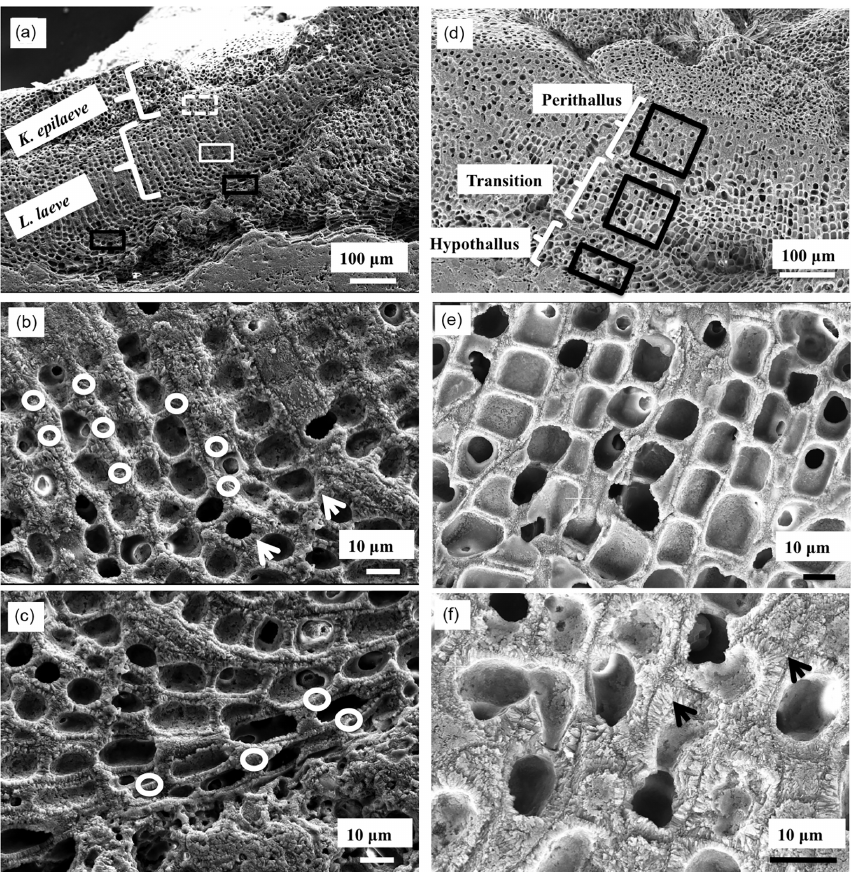
Figure 3. Overview of L. laeve and K. epilaeve and EDS sites (white circles) in L. laeve . (a–c) Sites on the underside of the pebble. (d– f) Sites on the upper side of the pebble. (a) White dashed box – cell wall and interfilament in K. epilaeve . White box – perithallial cell wall L. laeve . Black box – hypothallus L. laeve . (b) EDS sites for cell wall measurements of L. laeve . Circle size indicates approximate area of measurement (3µms). Cell wall radial Mg-calcite (arrowheads). (c) EDS sites for hypothallus (right box in a ). (d) EDS sites on sample upper side for L. laeve . (e) L. laeve. (f) L. laeve. Cell walls in upper side are visually comparable to cell walls in underside with radial Mg-calcite (arrowheads) in cell walls and minimal